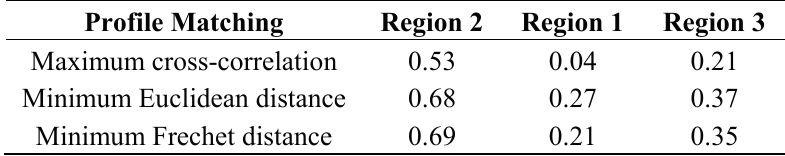
Table 3. Overall classification accuracies of profile matching by